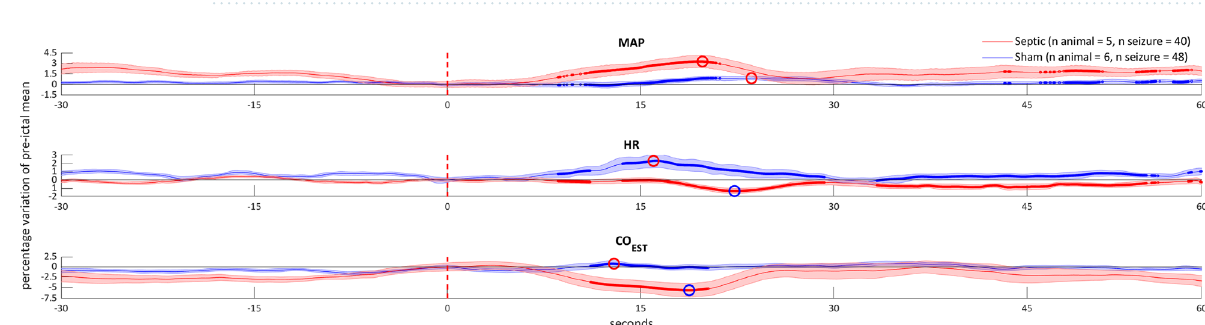
Figure 2. Temporal evolution of synaptic gain. In blue, mean ± SD seizure-induced value variation in time in sham group; in red, mean ± SD seizure-induced value variation in time in sepsis group. Mean and SD are calculated using bootstrapping with replacement and 100 iterations. Circles correspond to the peaks of a parameter variation (blue circles for the sham and red for the sepsis group). Time 0 corresponds to the seizure onset (vertical dashed red line). Differences between groups, identified by Wilcoxon Mann–Whitney rank sum tests, are bolded and calculated on the raw data without bootstrapping. For all the parameters, the descending part of the seizure-induced variation curve was steeper in the sham group. The dip was delayed in the sepsis group and particularly for the fast inhibitory synaptic gain variation that reached the dip with a lag of about 4.3 s (IQR [− 6.4–15] sec, P = 0.06, Table S3).